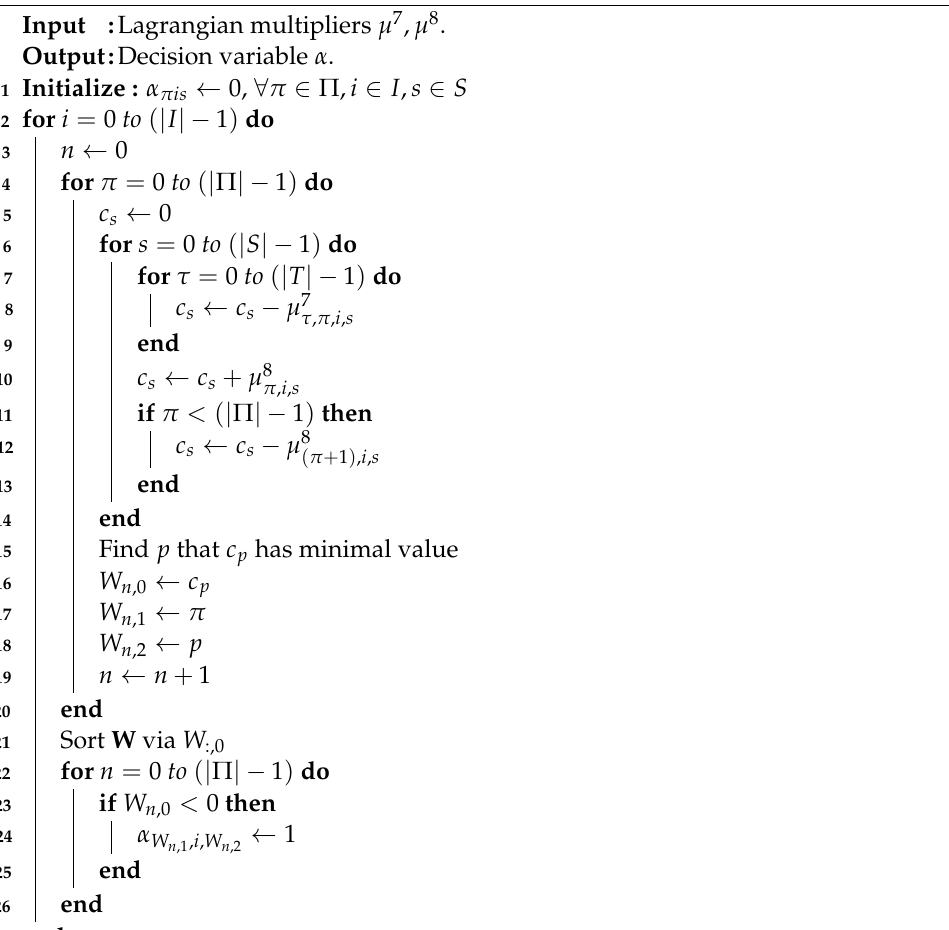
Algorithm 5 Sub-problem